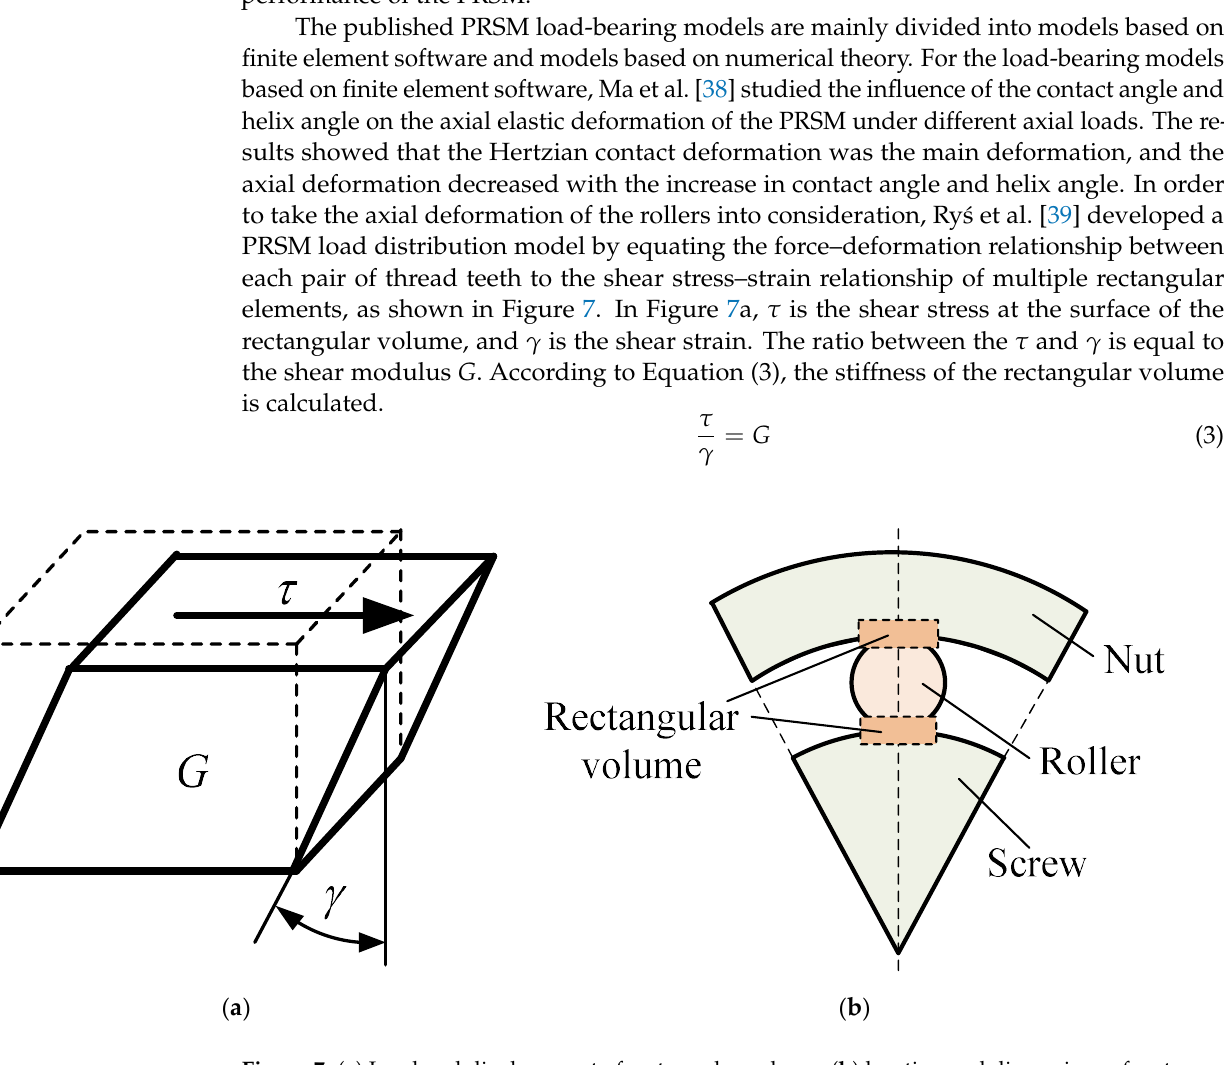
Figure 8. Sectoral model scheme of the simplified inverted PRSM in Ref. [44]. In order to save computing time, Abevi et al. [21] used beam elements, bar elements, non-linear spring elements and rigid-body elements to model the different components of the PRSM and their interactions (Figure 9), assuming that all materials were in the elas- tic range. The results obtained from this approach were compared to those computed with a three-dimensional finite element model, which suggested that the calculations were very accurate. Taking different assembly methods and force states into consideration, Liu et al.